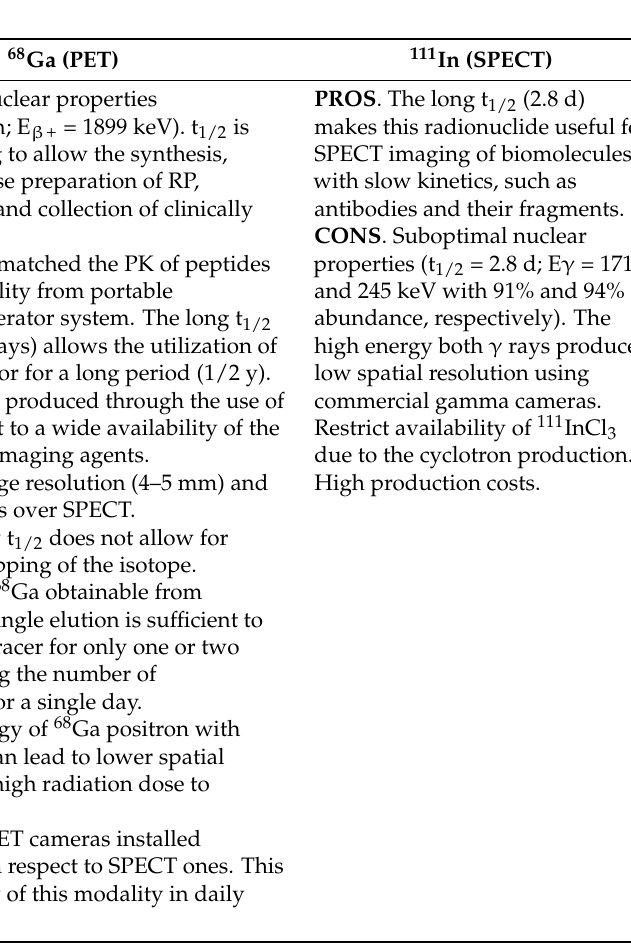
Table 1. Pros and cons of the use of Technetium-99m radionuclide vs. Gallium-68 and Indium-111